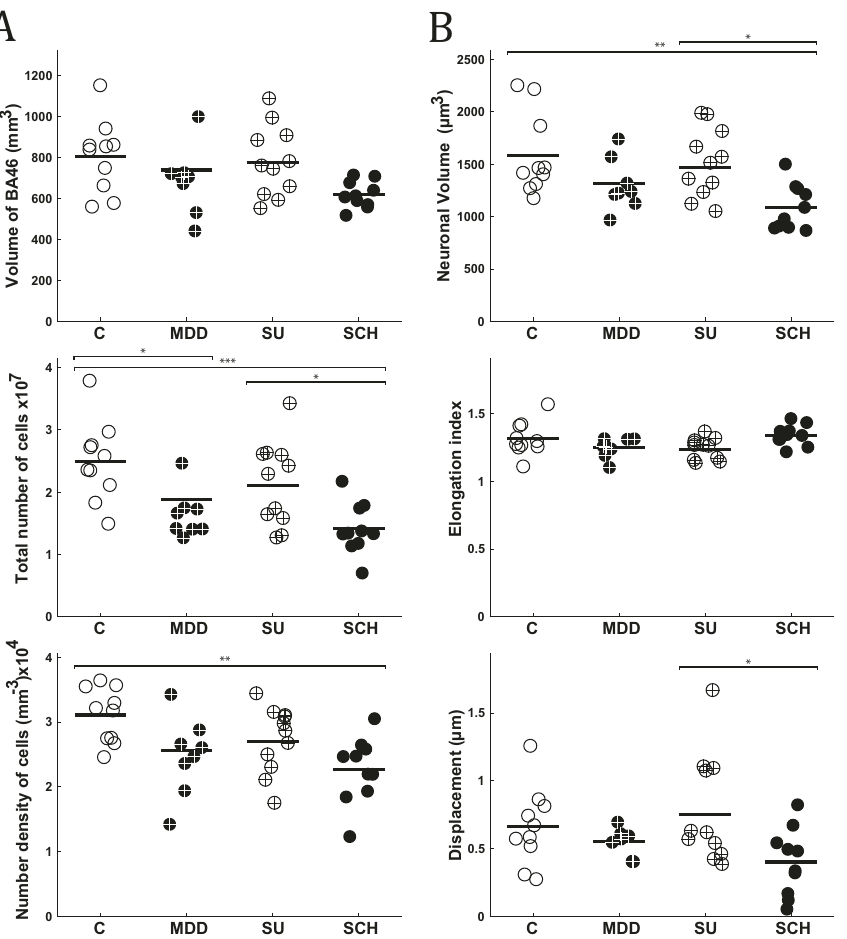
Fig. 5 Morphological results of the stereological analysis of BA46 in layer III. A Stereological measurements of the total volume, total neuronal number of pyramidal cells, and number density of pyramidal cells in layer III of BA46. B Volume tensor estimates of pyramidal cell somal size and shape in layer III of BA46, including volume, elongation index, and displacement. Control (C), Major depressive disorder (MDD), Suicide (SU), and Schizophrenia (SCH). ∗ P < 0.05, ∗∗ P < 0.01, ∗∗∗ P < or schizophrenia. If the neuronal volume is altered, the shape cannot be expected to remain constant. The sphericity was used to assess the shape measurements of pyramidal cells and the shape does not change even when the volume decreases due to SCH, suggesting the volume loss is homogeneous. Spatial point pattern analysis The cylindrical K -function was used to analyze the neural organization of centroids of pyramidal cells in layer III of BA46. We discovered signi fi cant evidence of a columnar structure in the direction of the x -axis in 27 subjects, especially when we looked at cylinders with radii ranging from 5 to 20 µm. As a result, smaller columnar formations perpendicular to the pial surface may represent the smallest functional unit of the mammalian brain ’ s cerebral cortex. Human minicolumns have previously been measured to have radii ranging from 17.5 to 30 µm [66 – 70]. However, the fact that the neural organization in 3D space was evaluated using 2D techniques may have resulted in misrepre- senting biological structures and cell malpositioning in 3D space. Furthermore, while those 2D approaches rely on a priori models that assume a minicolumnar structure, our methodology does not. Moreover, the 2D procedures used to investigate minicolumns were used in different locations compared to BA46. Aside from practicing different methodologies, the variation in minicolumn